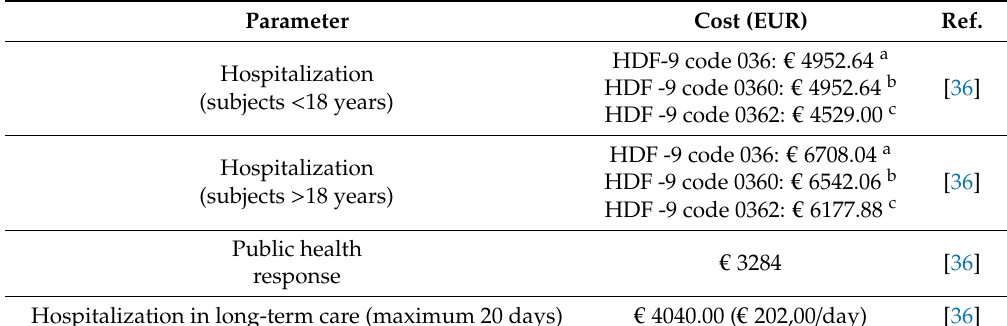
Table 2. The direct costs associated with acute-phase